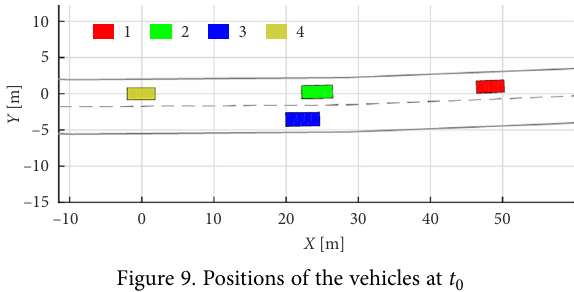
Figure 9. Positions of the vehicles at t 0 (source: created by the authors)